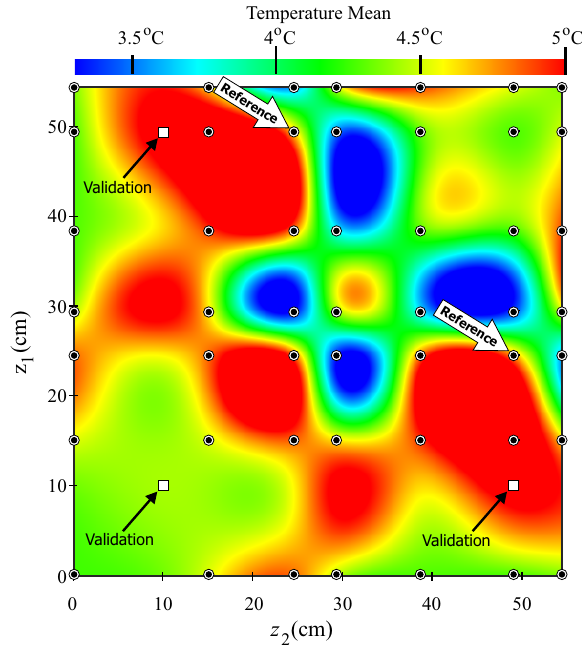
Figure 7. Thermal simulation using cubic spline interpolation.